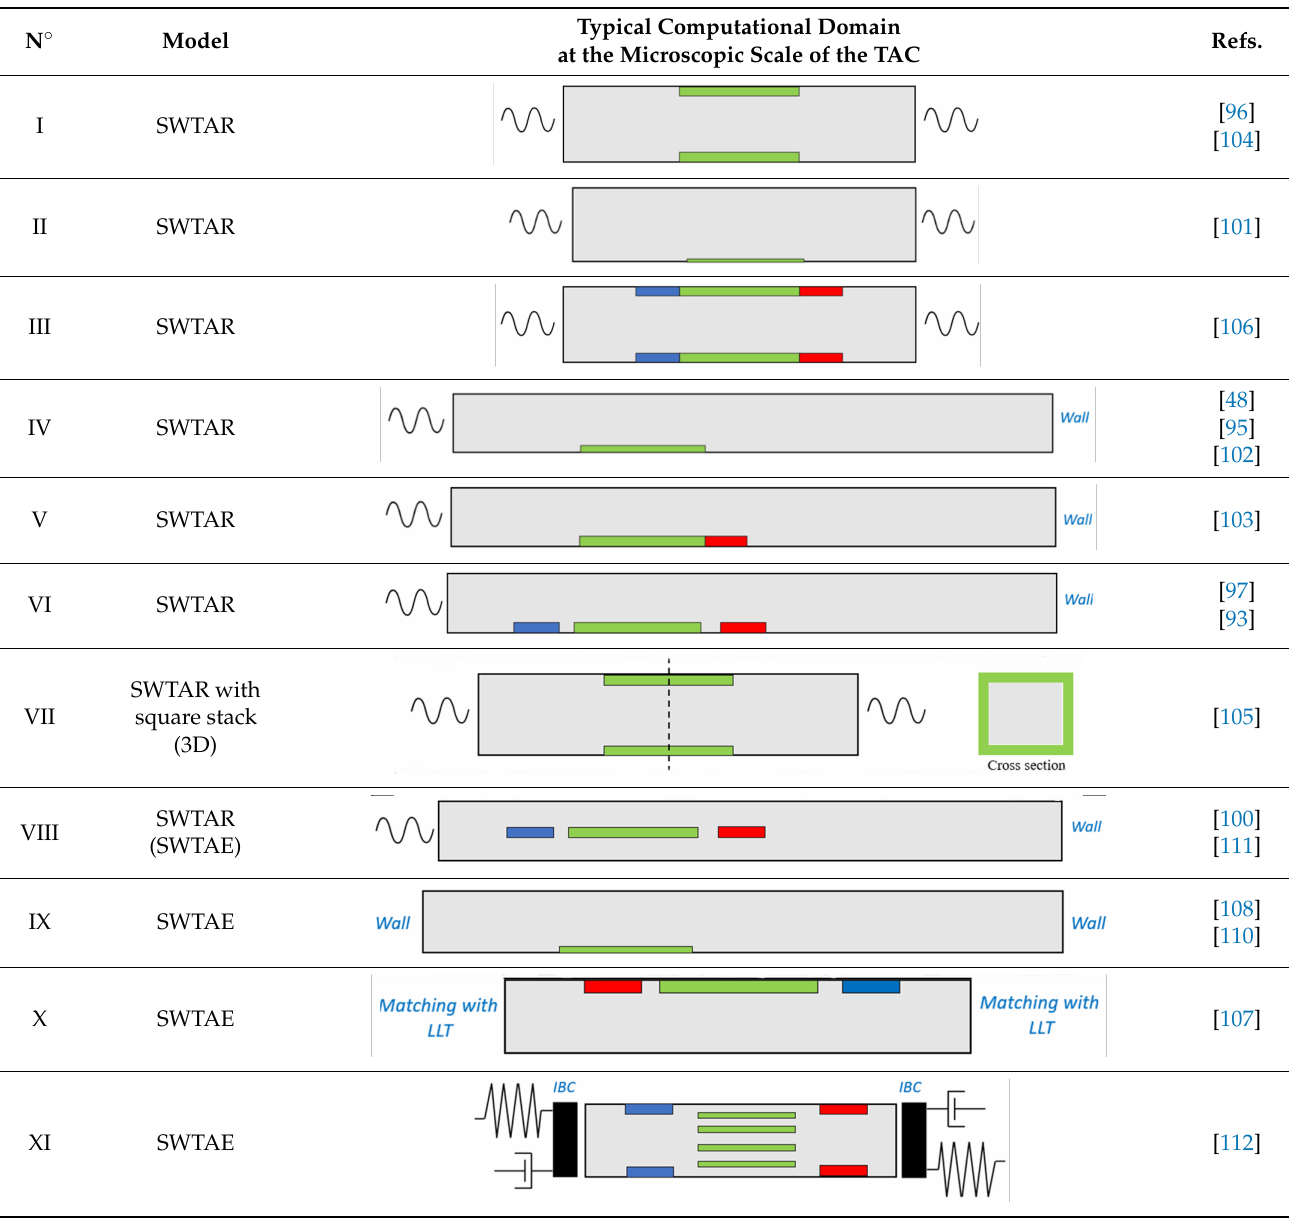
at the Microscopic Scale of the TAC